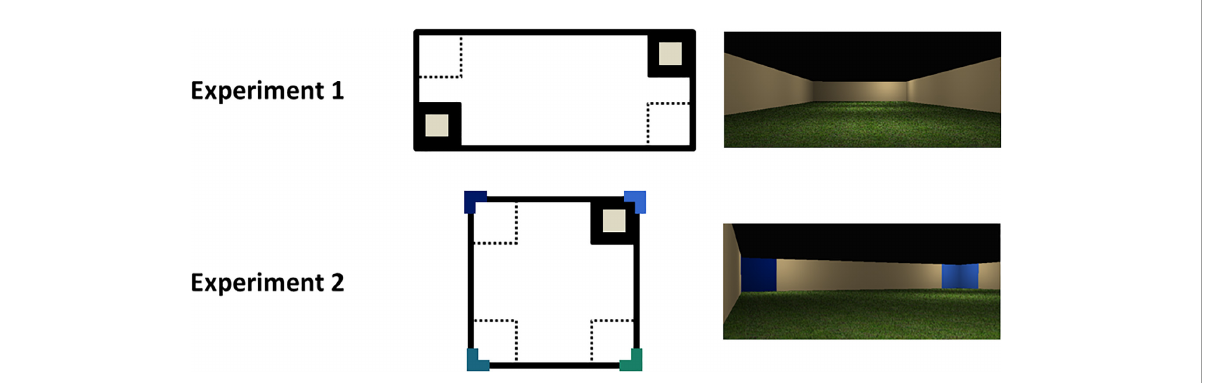
FIGURE1 Schematic and photographs of the virtual environments used in the two experiments. The small gray squares represent the goal locations; the colored L-shapes represent the colored wall panels. The solid black and dotted squares represent the correct and incorrect zones, respectively, for the purpose of analysis.